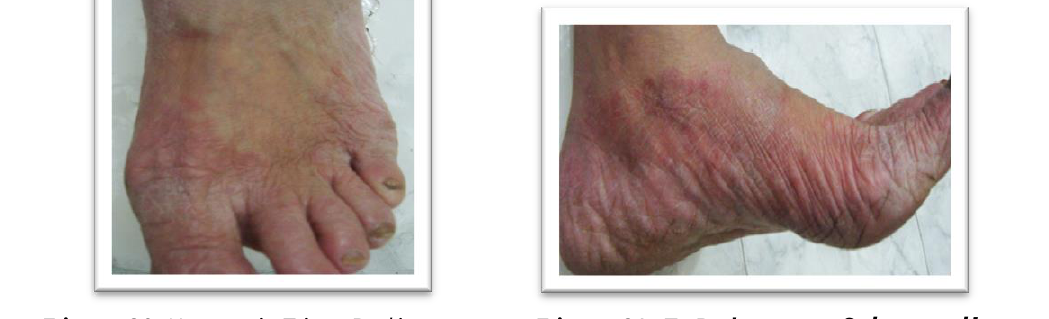
Figure 20 : Moccasin Tinea Pedis Figure 21: T. Rubrum on Sabouraud's aga